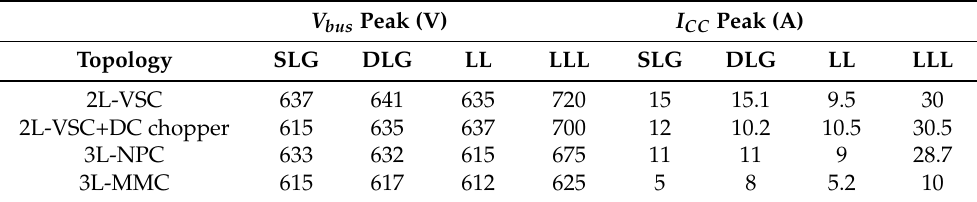
Table 5. Performance assessment heat